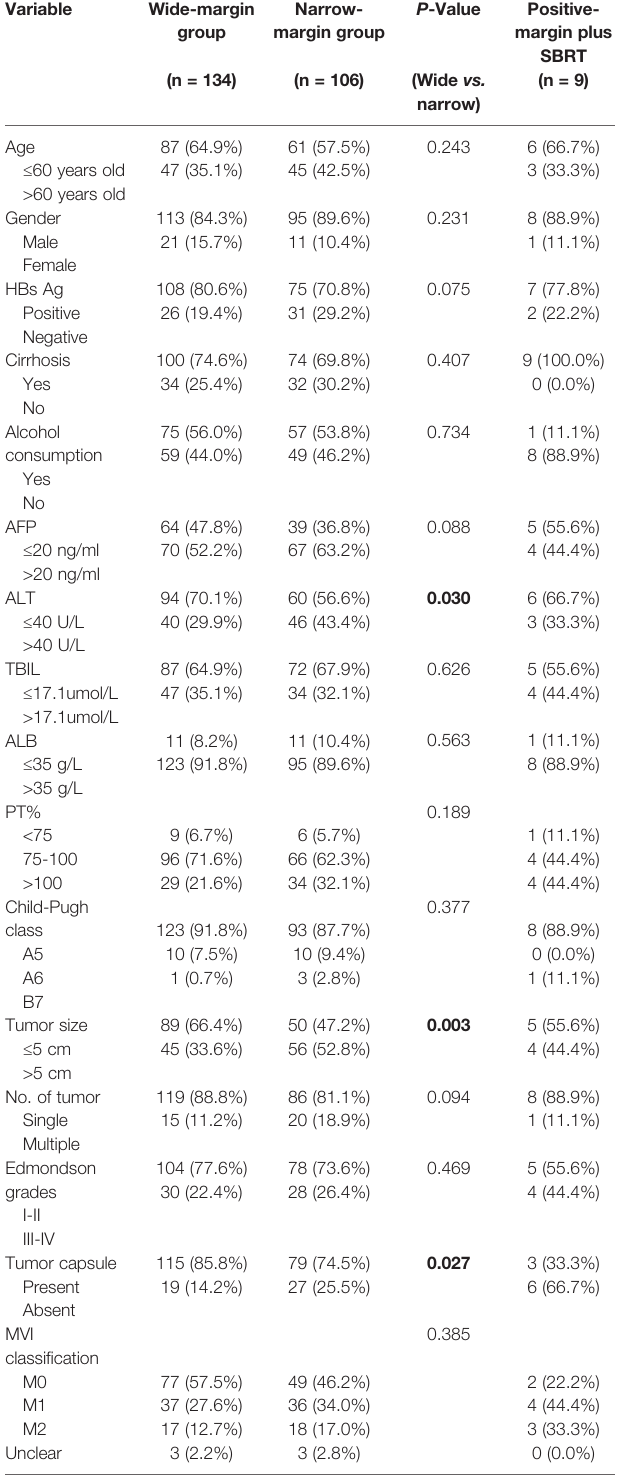
TABLE 1 | Demographic and clinicopathological characteristics of wide-margin, narrow-margin, and positive-margin plus stereotactic body radiotherapy (SBRT)